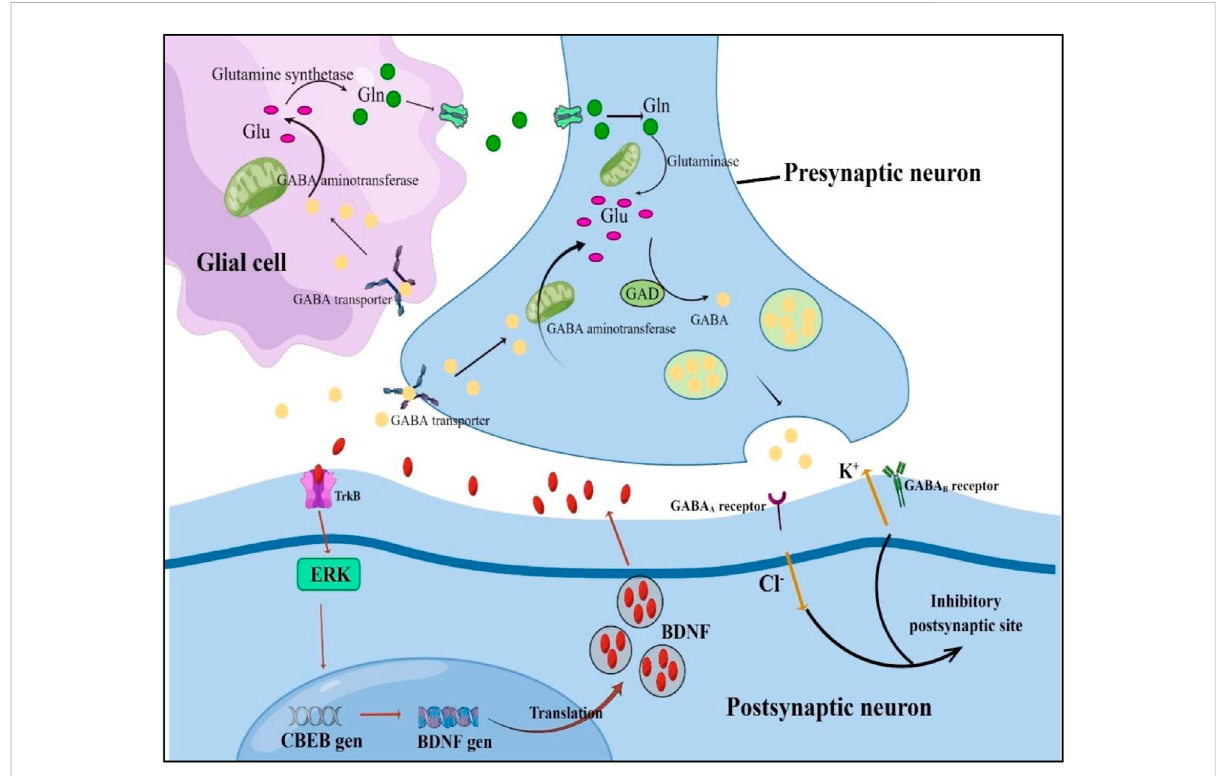
FIGURE 4 Schematic diagram of GABAergic and CREB/BDNF signaling pathways. Glu, glutamic acid; Gln, glutamine; GABA, gamma-aminobutyric acid; GAD, glutamate decarboxylase; ERK, activation; TrkB, tropomyosin receptor kinase; CBEB, cAMP response element-binding protein; BDNF, brain- derived neurotrophic